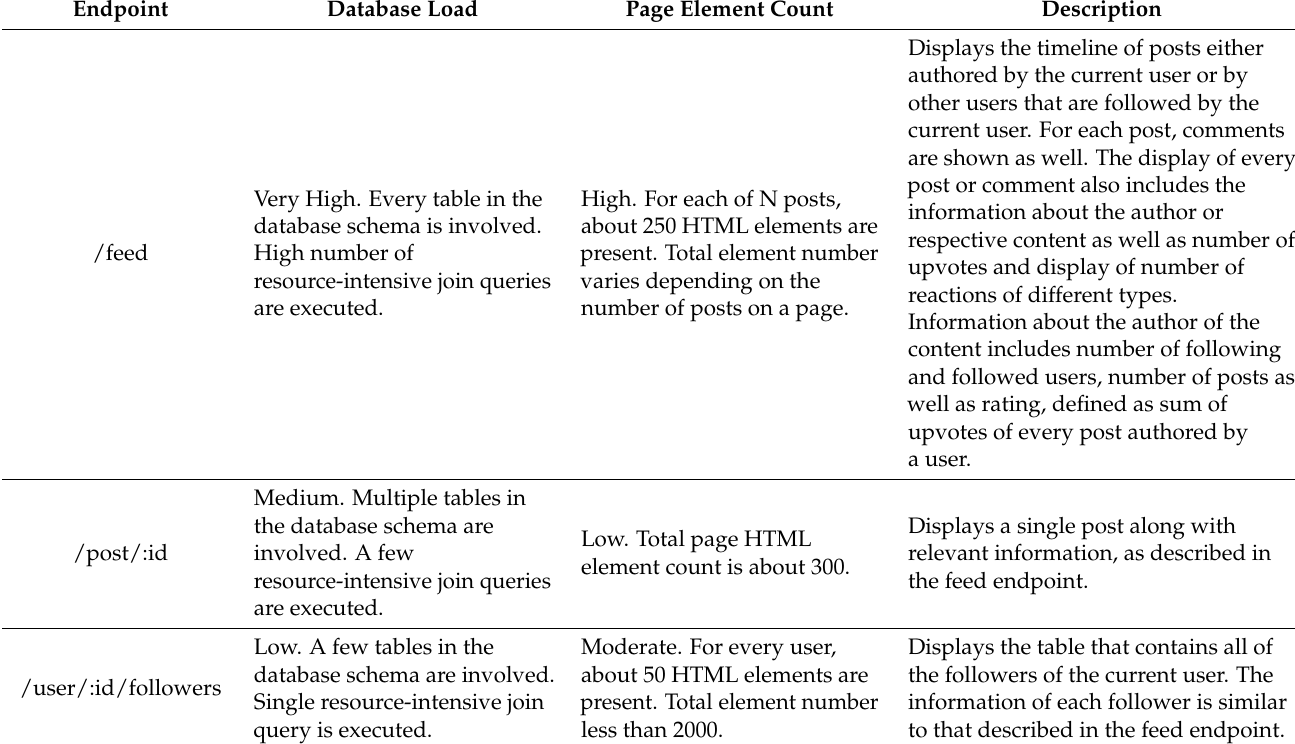
Table 1. Specification and general description of benchmark application test